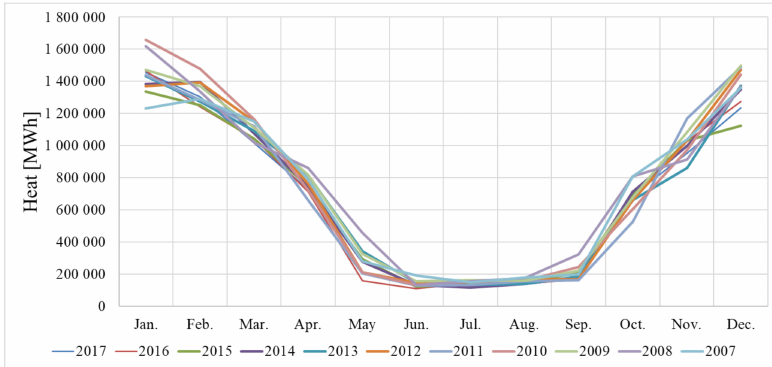
Figure 3. Unnormalized trends of the amount of thermal power produced for each month of the year. The source is DH plant’s heat meter data (supply and return temperatures and flow